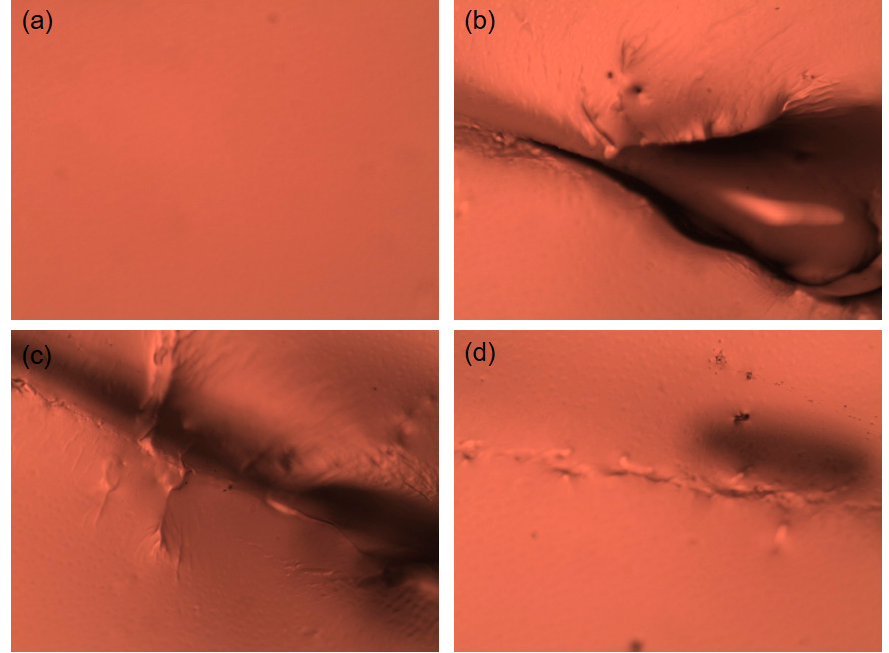
Figure 5. Optical microscope images of the self-healing process of supramolecular hydrogel: ( a ) initial hydrogel; ( b ) damaged hydrogel; ( c ) after healing 0.5 h; ( d ) after 5 h healing.